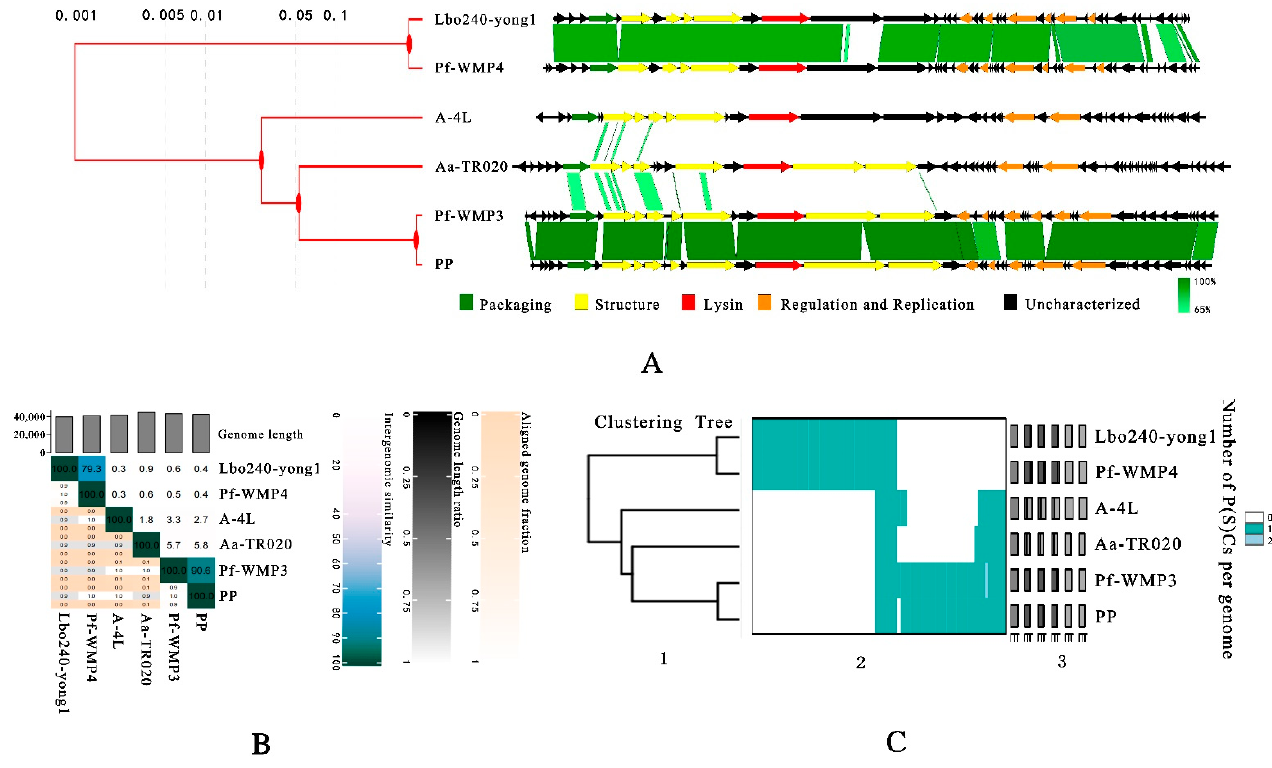
Figure 6. ( A ) Concatenated phylogenetic tree byViPTree (left) and by Easyfig of the six freshwater cyanopodoviruses. The homologous regions are represented by green bars. Light green to dark green represent low to high similarity. ( B ) Percent intergenomic similarities between the six freshwater cyanopodoviruses, calculated by the VIRIDIC server. ( C ) Integrated visualization of the viral cluster- ing output of VirClust. 1. Hierarchical tree calculated using the protein cluster-based intergenomic distances. 2. Heatmap representation of the protein cluster distribution in the viral genomes. Rows represent the individual viral genomes. Columns represent the individual protein clusters. 3. Viral genome-specific statistics: genome length, the proportion of proteins shared (dark grey) from all proteins (light grey bar), and the proportion of proteins shared in the own viral genome